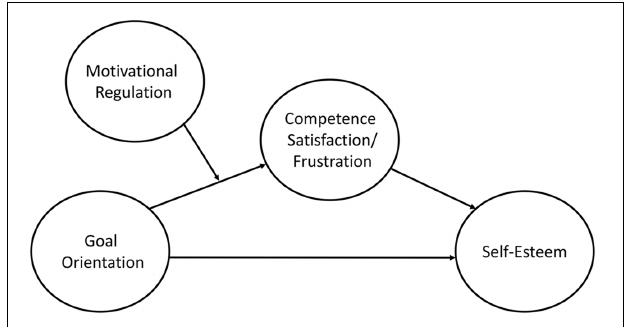
FIGURE 1 | The conceptual conditional process